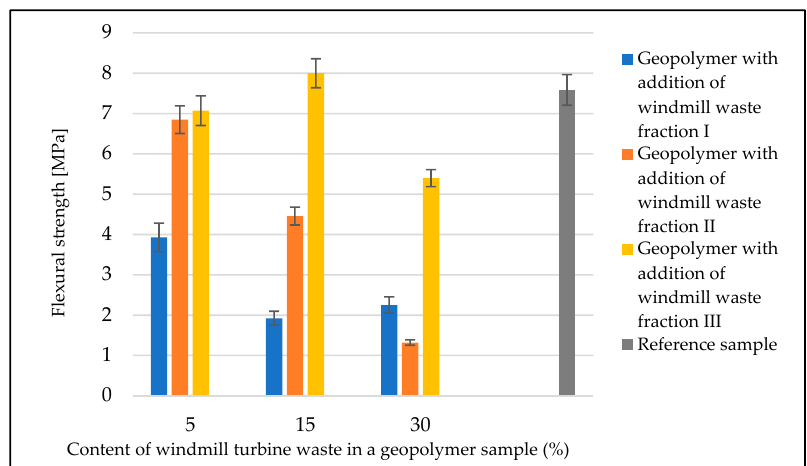
Figure 10. Flexural strength of geopolymer samples with the addition of waste fractions from windmill turbines.